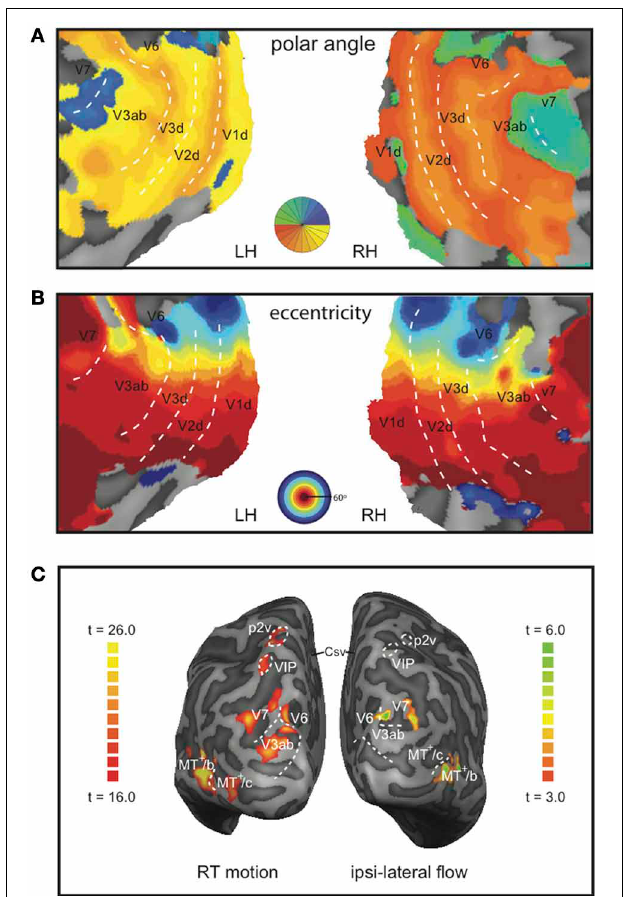
FIGURE 3 | Representative example of the demarcation of the ROIs and the BOLD responses. Flat map representation of the dorsal-occipital part of the left and right hemisphere of a single subject with a color map of the phase angle mapping (A) , or eccentricity mapping (B) ; both: correlation coefficient r > 0 . 3. Dotted lines demarcate the main visual areas. (C) Inflated representation of the left and right hemisphere of the same subject. On the left hemisphere, the result of a GLM contrast between all motion conditions vs. static is depicted (RT motion runs). The right hemisphere shows the result for a contrast between right-hemifield flow vs. static (MT + -localizer runs).